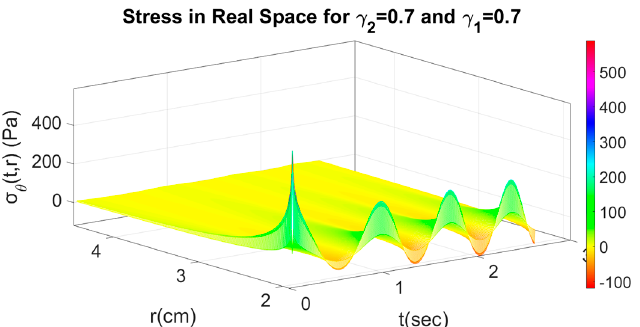
Figure 19. Distribution of the stress σ θ ( t , r ) in the initial space with space (porosity) fractional order γ 1 = 0.7 and time fractional order γ 2 = 0.7.